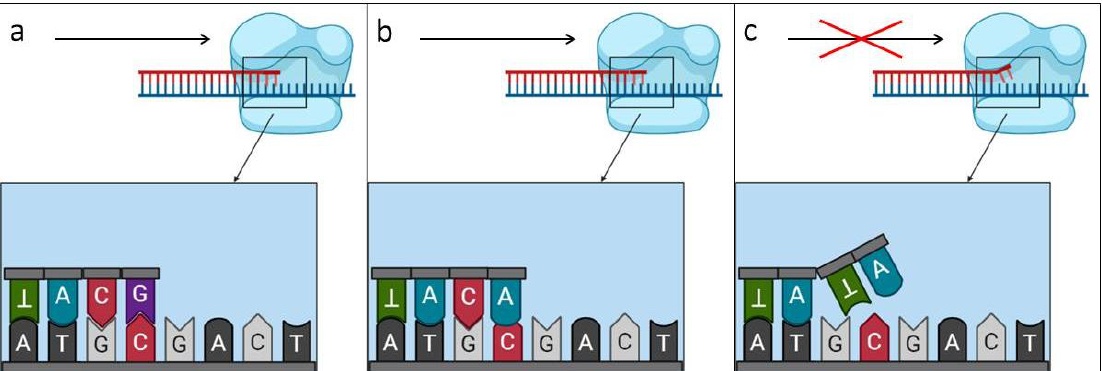
Figure 3. Scheme of attachment of the modified primer and the occurrence of a “ floating tail ” on